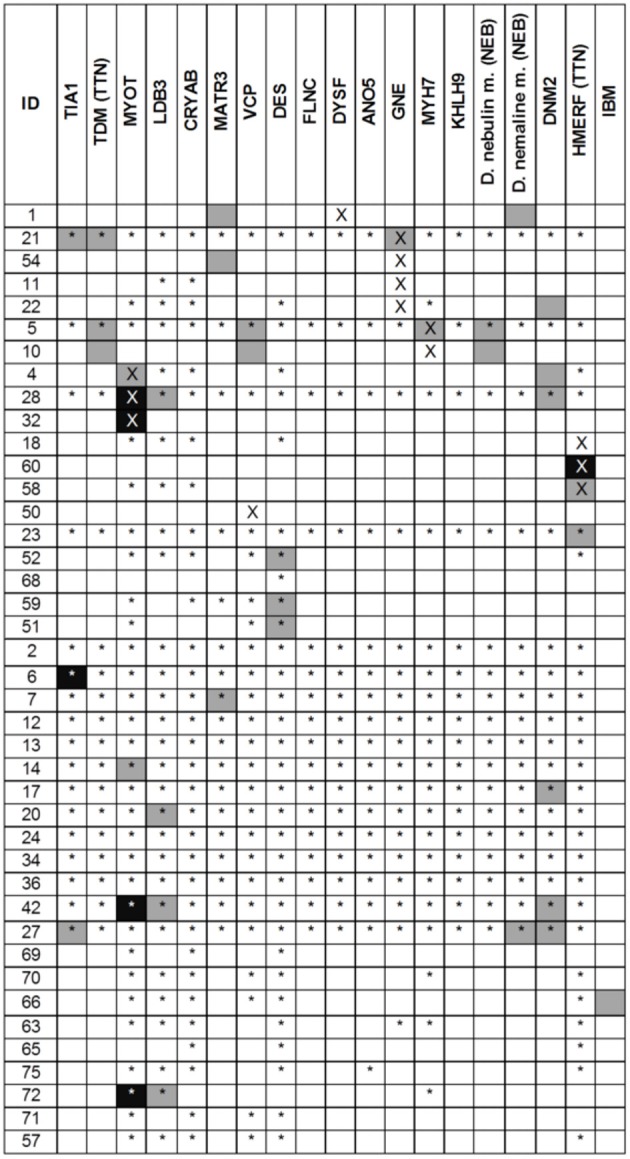
Results of the MRI pattern analysis. In black the disease scored as typical and in gray as consistent. A cross indicates the gene identified as pathogenic whereas the star indicated a negative genetic test. For TTN and NEB two different phenotypes were considered. Variants of uncertain significance in DES gene were found in ID 23, 52, 68, 59, 51.